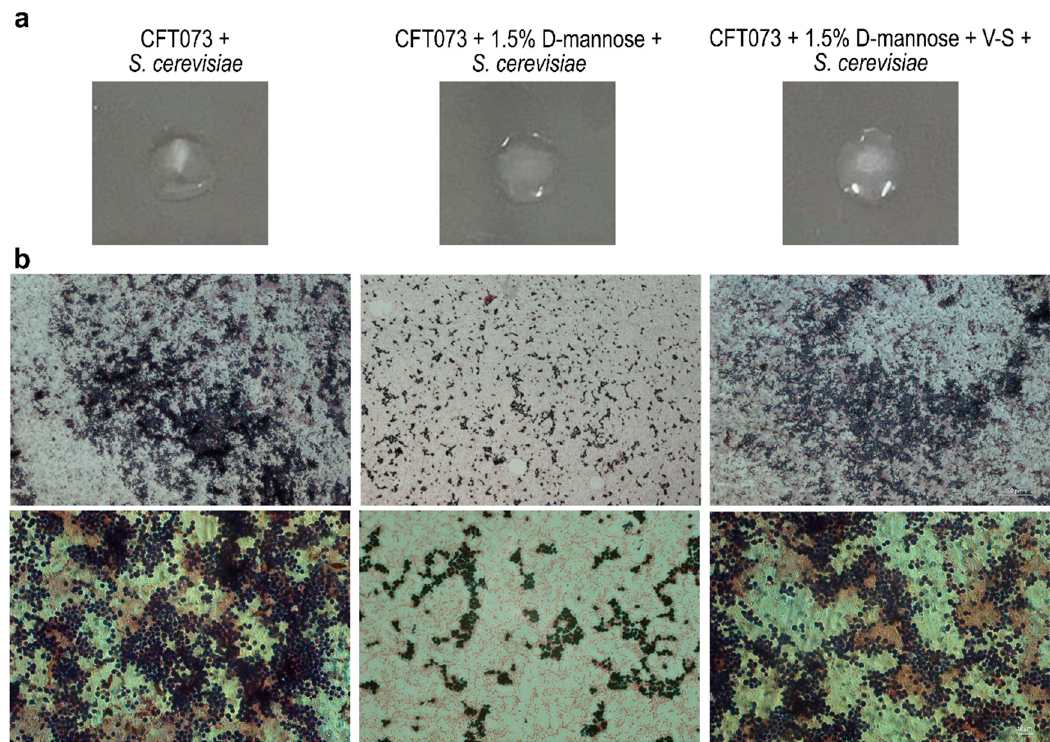
Figure 4. Representative images of yeast agglutination activity of E. coli after removal of d -mannose from FimH. Strain CFT073 grown in the presence of d -mannose was vortexed and sonicated to break FimH– d -mannose bonds (referred to as V-S bacteria). Thus, E. coli suspensions of untreated, d -mannose-treated, and d -mannose-treated V-S bacteria were tested for yeast cell agglutination on microscope slides. ( a ) Macroscopic images of yeast agglutination assay. ( b ) Microscopic images of Gram-stained yeast agglutination assay recorded with the 10 × (upper panels) and 40 × (lower panels) objectives using a Leica DM5000B microscope and processed using the Leica Application Suite 2.7.0.R1 software (Leica). Scale bars: 100 and 10 μ m.